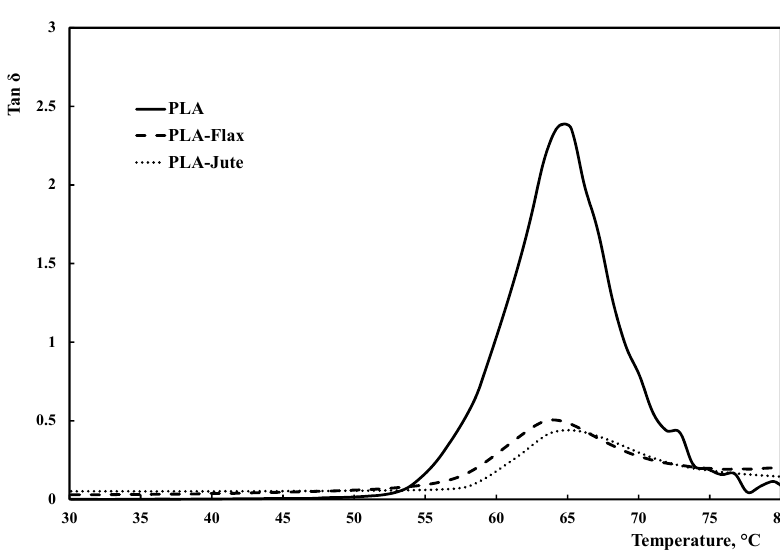
Figure 3. Tan δ versus temperature trends.